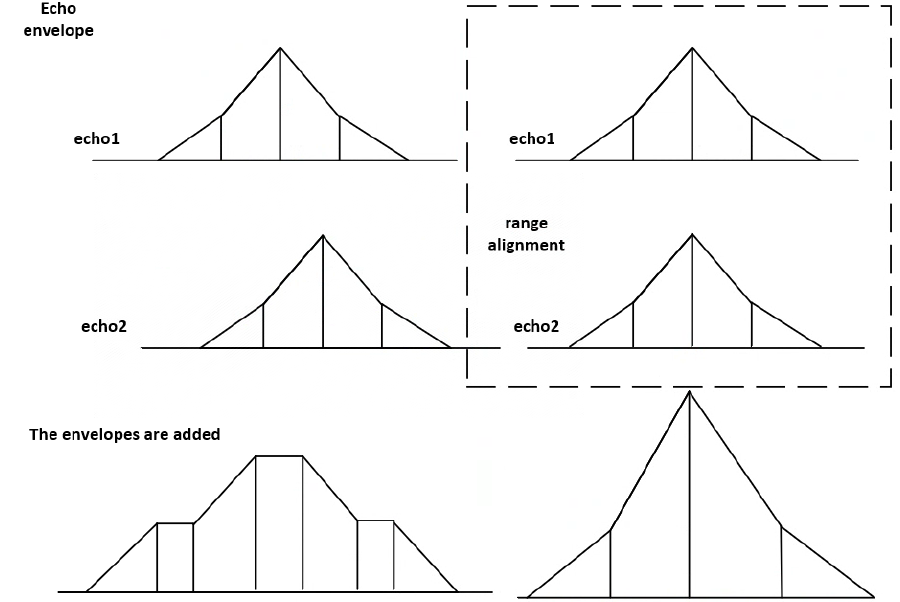
Figure 3. Schematic diagram of the front and rear envelopes of target echo alignment.